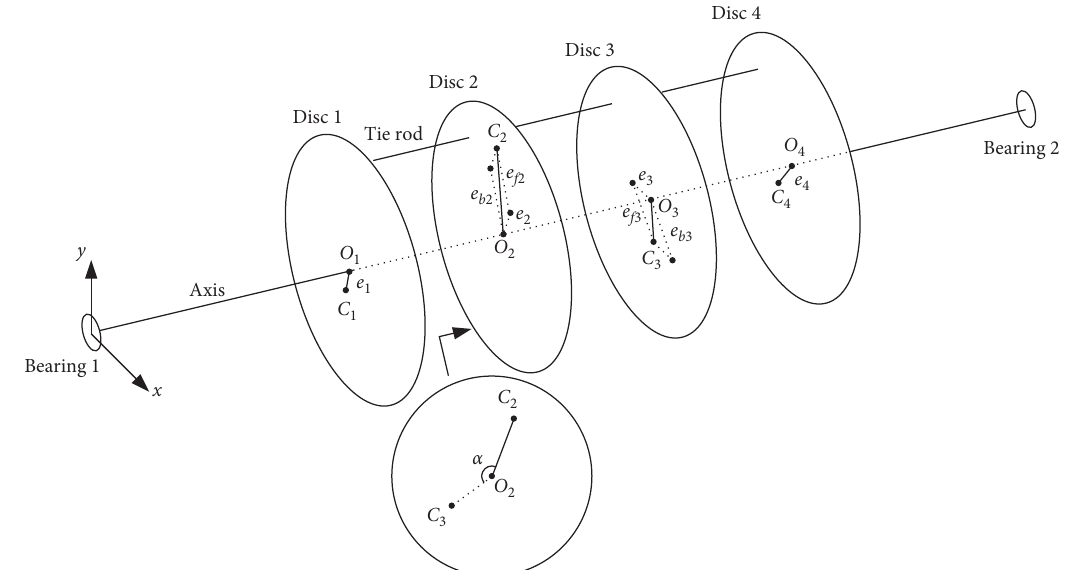
Figure 2: Schematic diagram of fault location of rod fastening